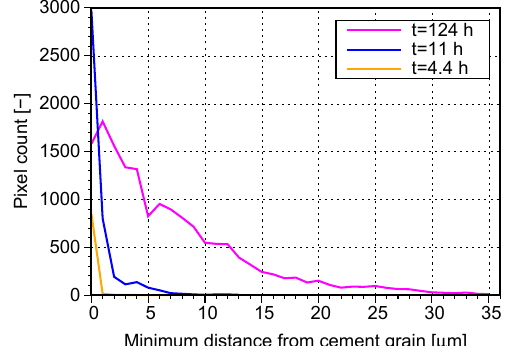
Figure 6. Quantification of the spatial distribution of amorphous hydrates as a function of the minimum distance from the cement grain.